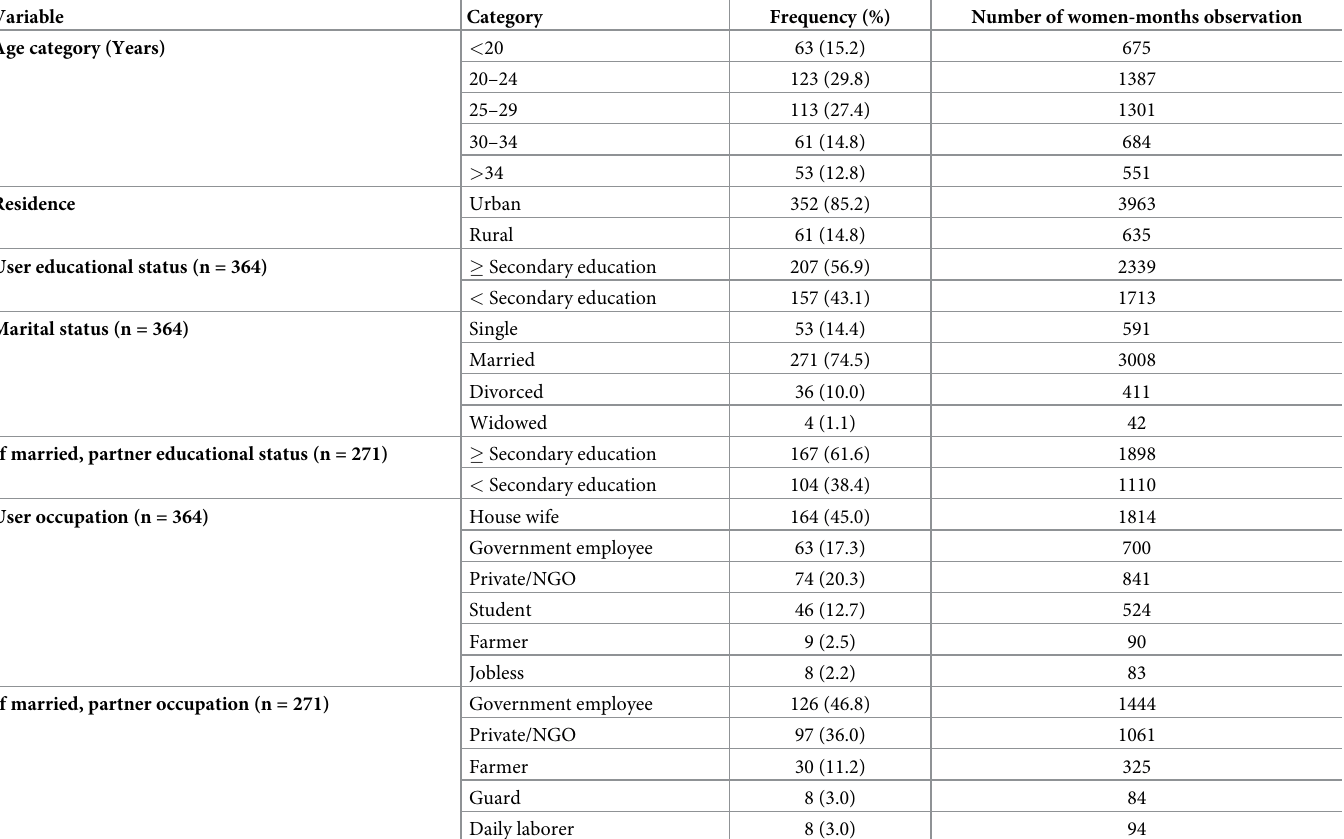
Table 1. Baseline sociodemographic characteristics of the study participants at Ayder comprehensive specialized hospital, Mekelle, Northern Ethiopia, 2016–2017 (n = 413).